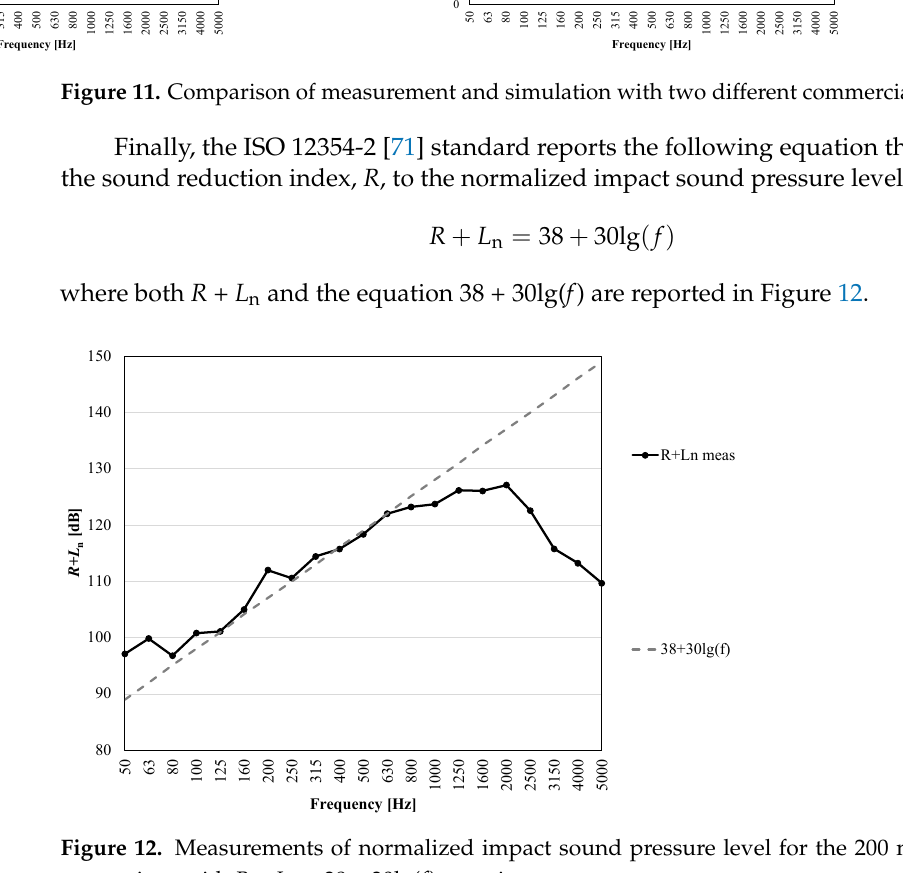
Figure 11. Comparison of measurement and simulation with two different commercial software.